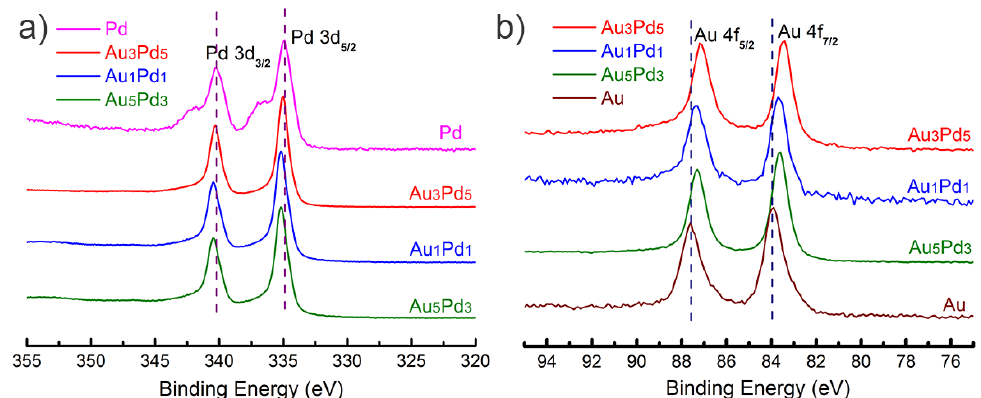
Figure 6. XPS data of ( a ) Pd 3d and ( b ) Au 4f core levels of Pd, Au3@Pd5, Au1@Pd1, Au3@Pd3 DNPs and Au NPs.